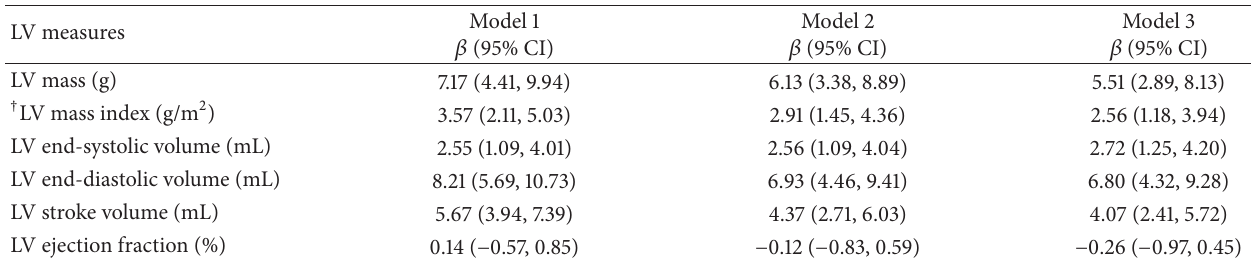
Table 4: Multivariable adjusted differences in LV measures and ejection fraction by presence of a prolonged PR interval ( > 200ms) versus PR interval 120–200